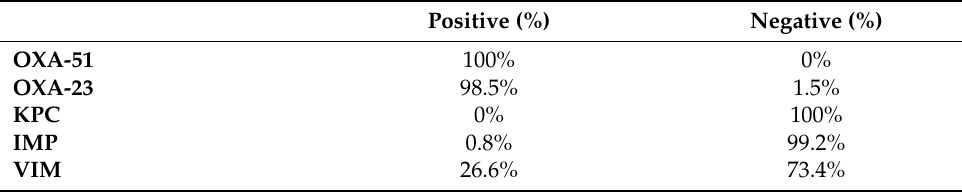
Table 6. Carbapenem resistance genes among A. baumannii